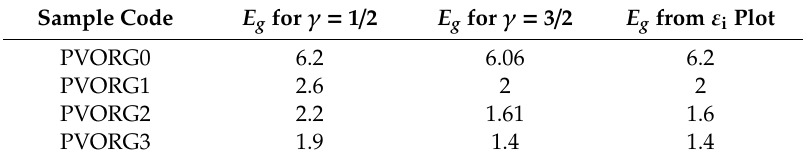
Figure 14. Plot of ( α h υ ) 2 vs. photon energy for pure PVA (PVORG0) and PVA composite films. Table 2. Opticalbandgap from Tauc’s method and optical dielectric loss